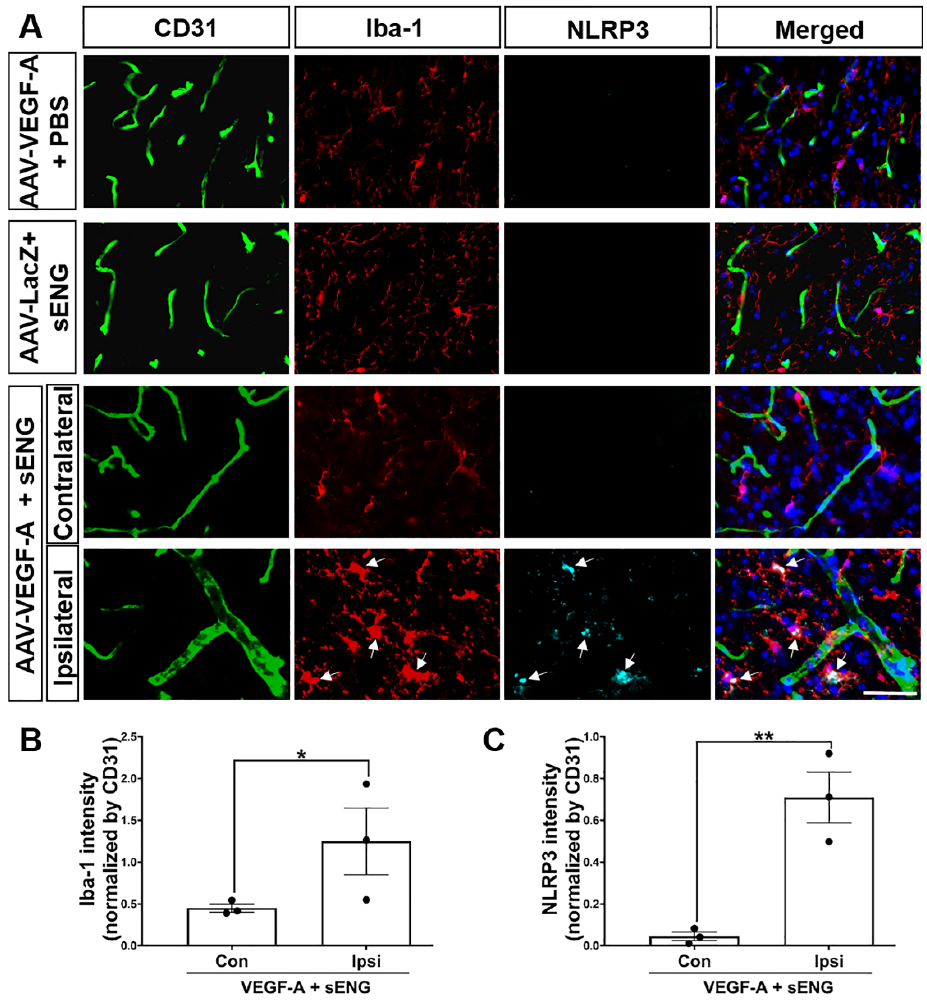
Figure 2. Soluble ENG/VEGF-A induced microglial activation with expression of inflammasome marker around dysplastic capillaries in mouse brain. ( A ) Immunostaining of mouse brain with CD31, Iba-1, and NLRP3 antibodies. Iba-1+ activated microglia are distributed around sENG/VEGF-induced dysplastic vessels in the mouse brain. Iba1+/NLRP3+ cells (arrows) indicate the inflammasome activation within the activated microglia. Scale bar: 50 μ m. ( B , C ) The quantification of intensity of Iba-1 ( B ) and NLRP3 ( C ) fluorescence normalized by CD31, respectively. n = 3; data are presented as mean ± SEM; * p < 0.05, ** p < 0.01 vs. contralateral; Student’s t- test.